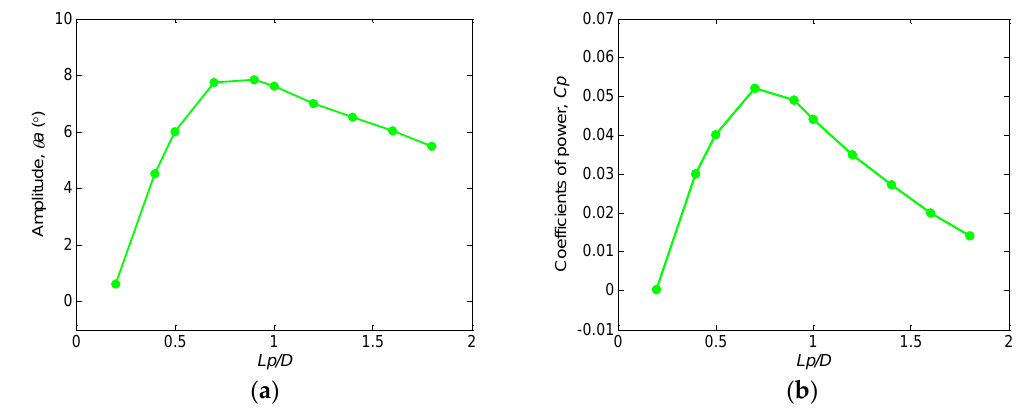
Figure 14. Effects of plate length on ( a ) oscillation amplitude and ( b ) C p .